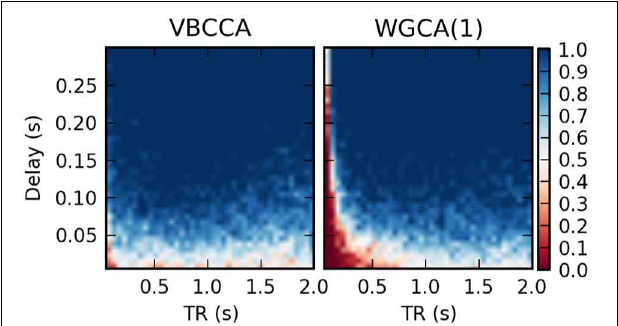
FIGURE 9 | Average d-Accuracy calculated over 50 simulations for a network with two nodes and a single connection for varying neuronal delays (40 steps between 5 and 300ms) and TR values of the fMRI scanner (40 steps between 50ms and 2s). The HRF is held constant for all simulations, the signal-to-noise ratio is 20dB. The proposed method is denoted VBCCA and we use P = 1, whereas WGCA(1) denotes the